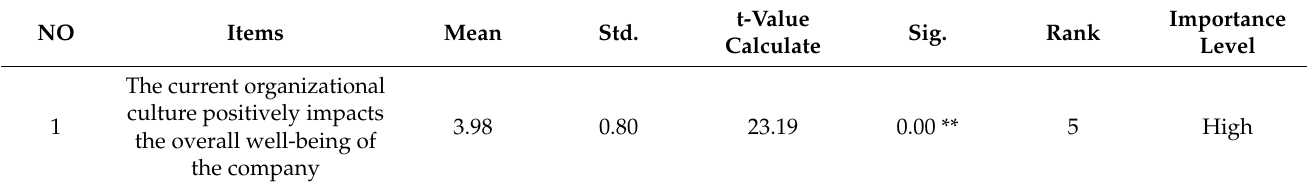
Table 4. Descriptive Statistics (Organizational